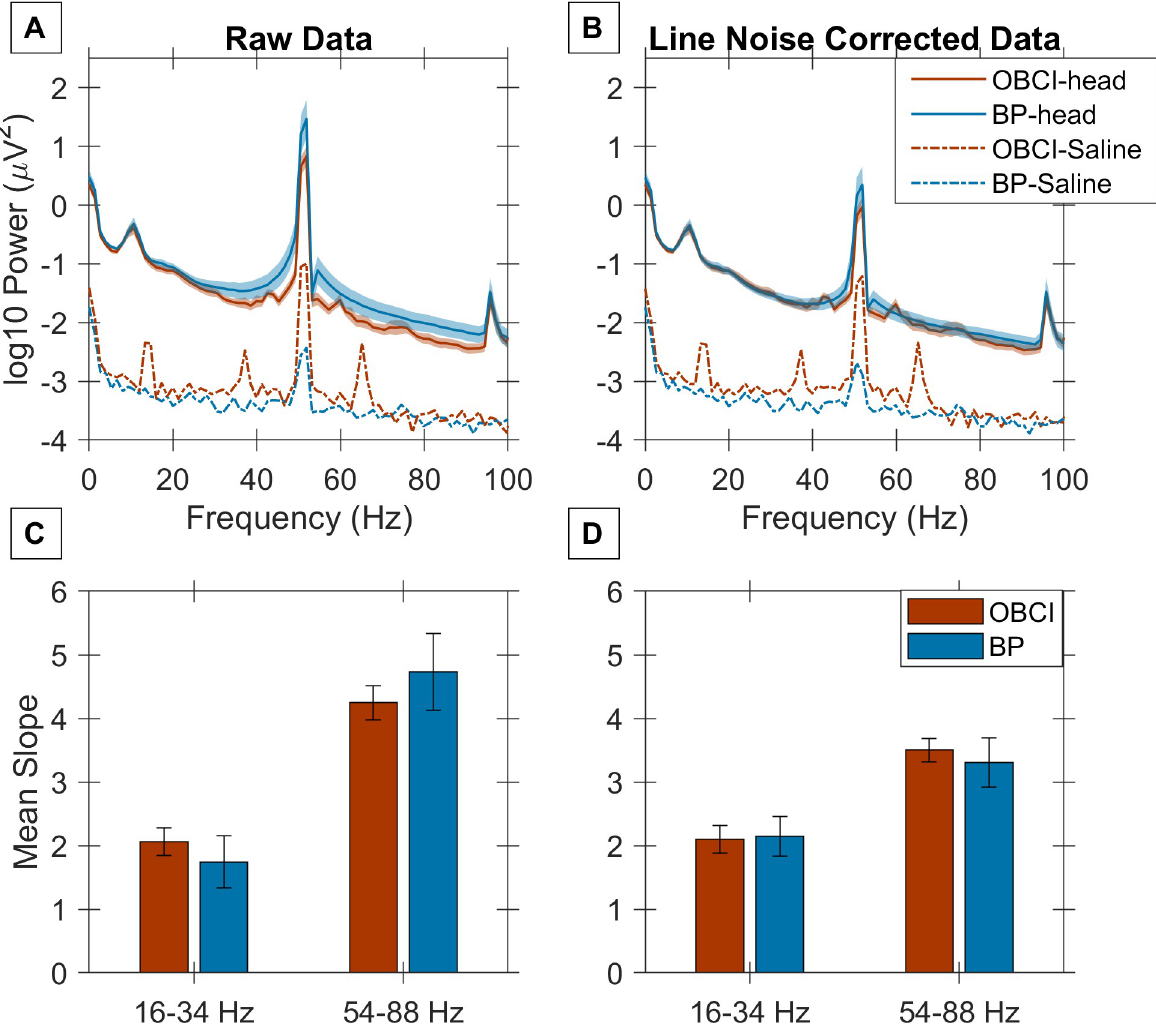
Fig 1. Slope comparison of OpenBCI and Brain Products at baseline. A) Baseline raw Power Spectral Density (PSD) for OpenBCI ( red trace ) and Brain Products ( blue trace ) averaged across 11 subjects (thickness of the trace indicates the standard error of PSD across subjects at each frequency). Dotted lines show PSD of shorted electrodes for instrument noise measurement. C) Slope of the PSD vs Frequency plot averaged across all subjects for two frequency ranges (16–34 Hz and 54–88 Hz) for OpenBCI ( red ) and Brain Products ( blue ). The error bars indicate the standard error. B, D) Same as A, C, but after selectively attenuating the mains/line noise component (see Methods for